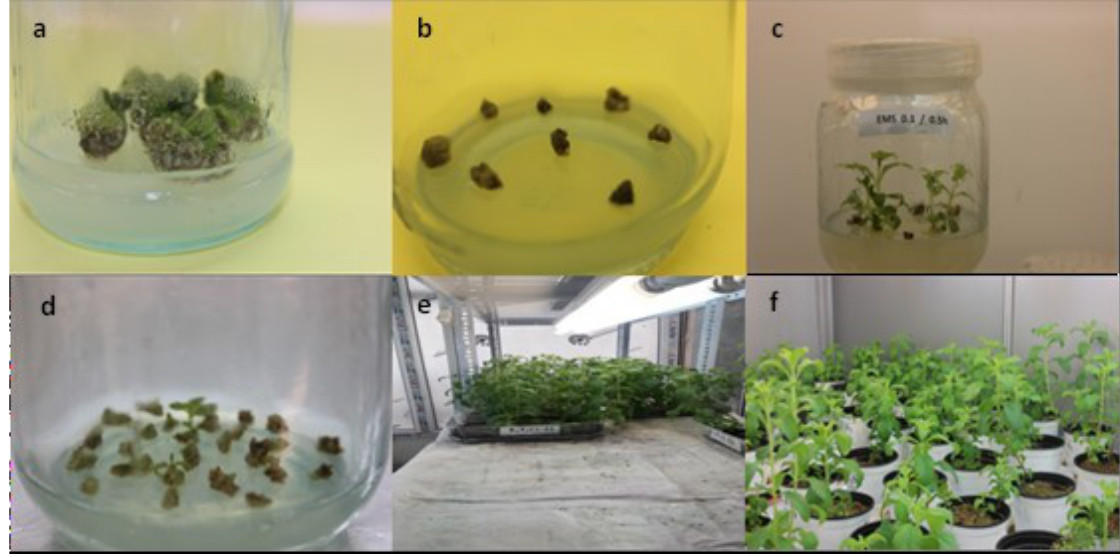
Fig. 1. Different steps of Stevia rebaudiana regeneration from EMS treated explants: (a), calli induced from leaf explants, (b), No regeneration from calli treated with 0.2% EMS for 120 minutes. (c), shoot regeneration from calli treated with 0.1% EMS for 30 minutes. (d), elongation of shoots regenerated from calli treated with 0.2% EMS for 30 minutes. (e), Acclimated plantlets (f), transfer plantlets into vases under salt